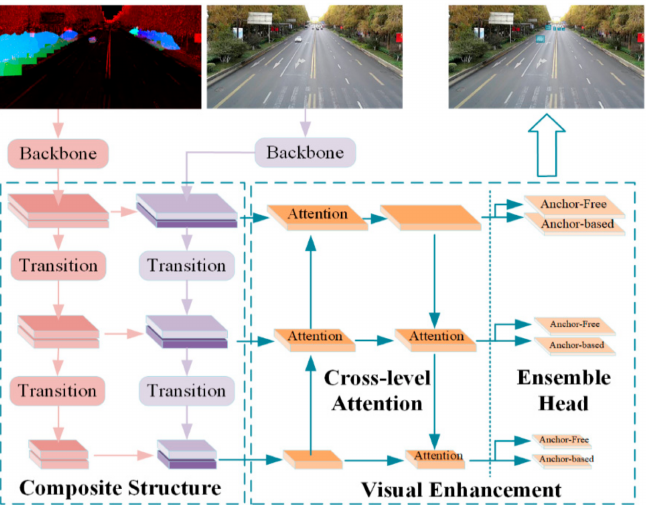
Figure 2. The overall design of the multi-sensor multi-level enhanced convolutional network archi- tecture (MME-YOLO) network. Our work creatively transmits the feature maps of the LiDAR subnet to the Image subnet in a recursive manner. Additionally, we develop cross-level attention blocks to strengthen the merged features. Then, the ensemble head is introduced for better generalization in real